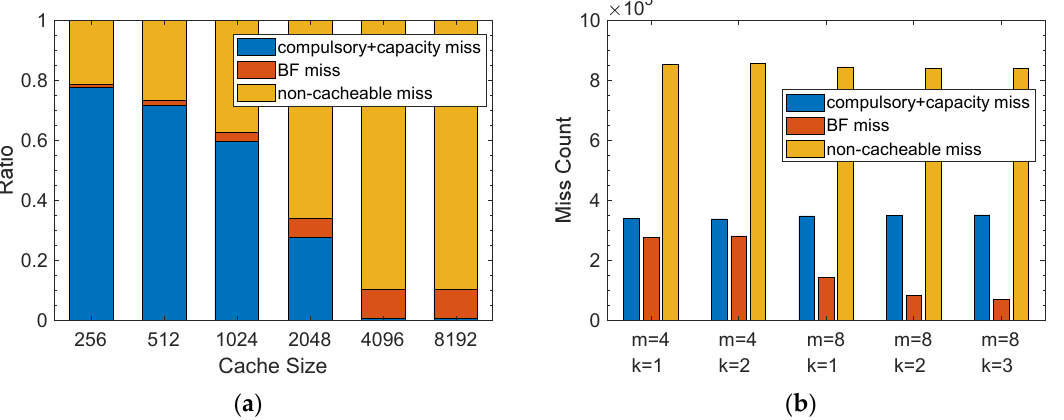
Figure 11. Observations with regard to the cause of cache miss: ( a ) distribution of cache miss count; ( b ) cache miss count against the Bloom filters with size m and the number of hash functions k when the cache size is 2048.